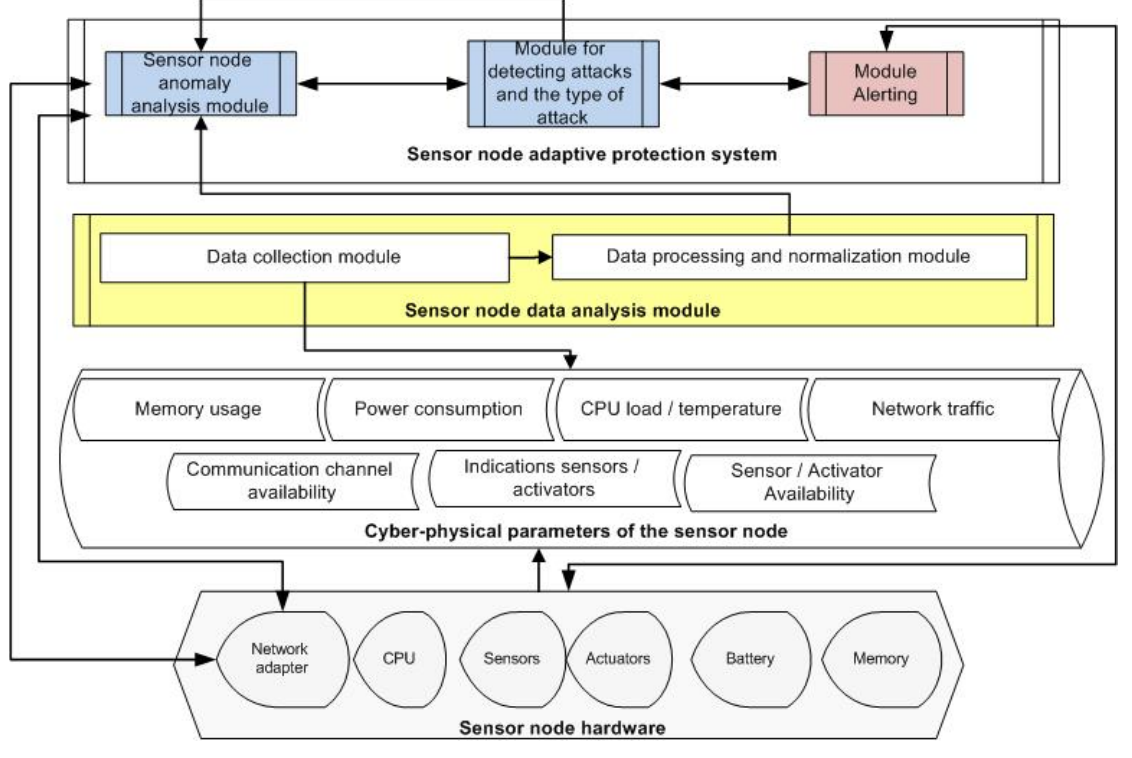
Figure 1. Block diagram of the adaptive protection system of the sensor node.